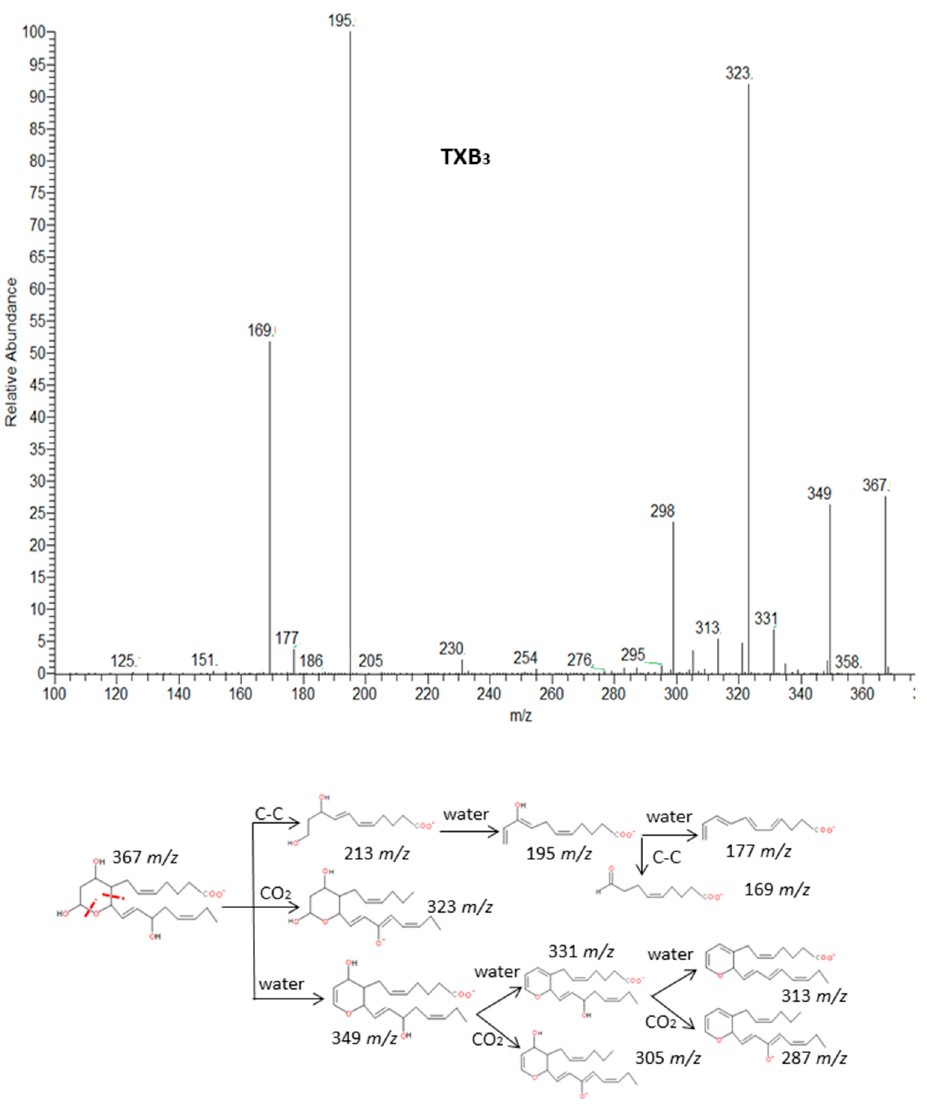
Figure 10. Fragmentation pattern suggested for TXB 3 . The product ion spectrum at m / z 367 was obtained from LIPID MAPS at CID 30V.